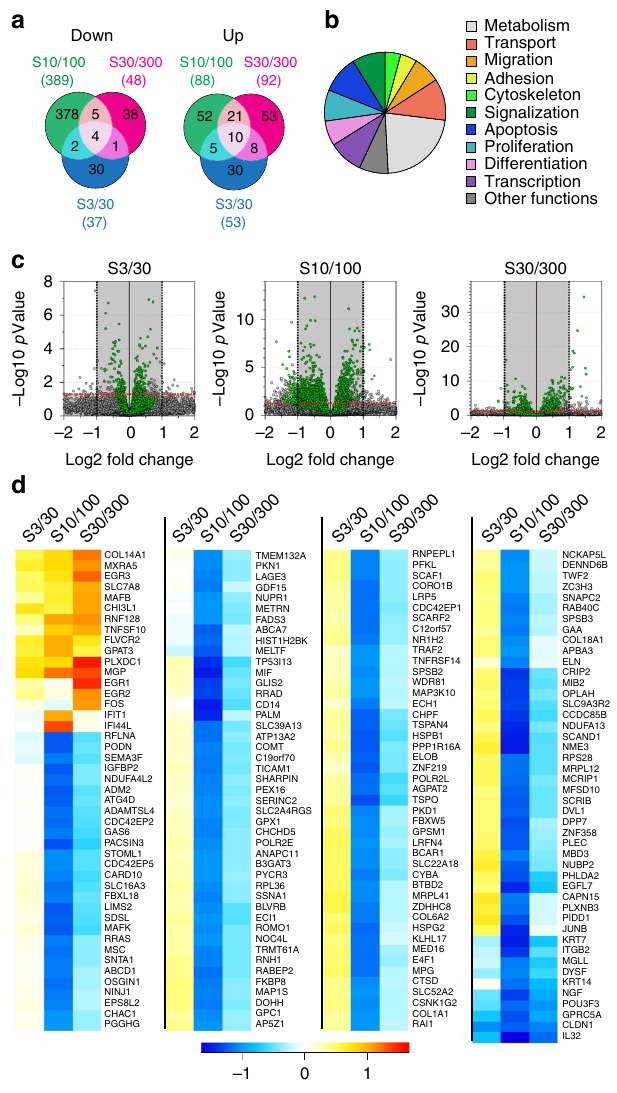
Fig. 6 Sinusoidal homothetic surfaces have distinct effects on hMSC transcriptome. a Venn diagram representation of the total up- and downregulated genes ( P value < 0.05 and Log2FC > 1) on sinusoidal surfaces using fl at as reference (637 genes total). b Functional enrichment analysis using GO annotations of biologically described genes (361 genes). c , d Volcano plot of all differentially expressed genes fi ltering out low expressed genes (gray shaded area, reads < 100) ( c ), resulting in the identi fi cation of 181 genes for which relative expression patterns are shown for the different sinusoidal surfaces ( d